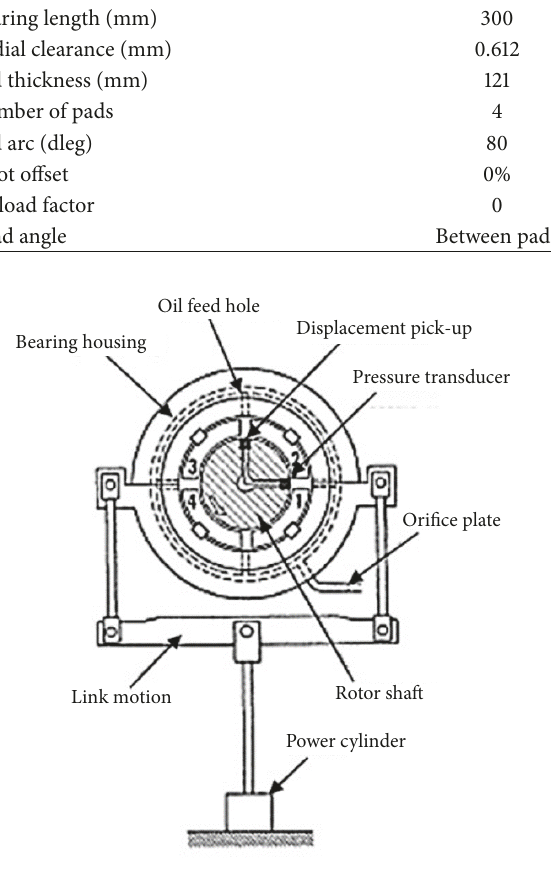
Figure 1: Geometry of the stream surface